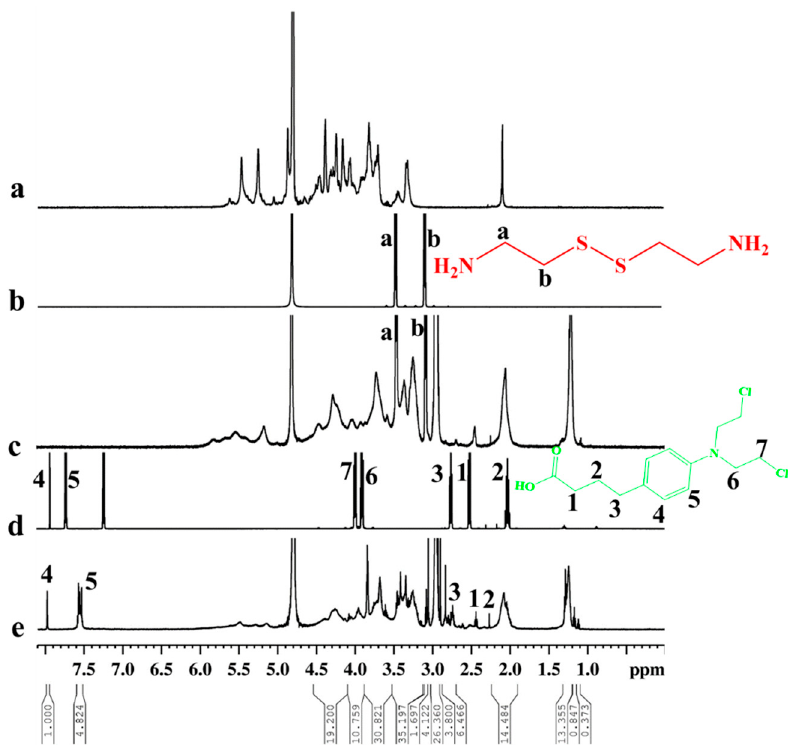
Figure 1. 1 H NMR spectra of Hep ( a ), cystamine (Cys) ( b ), Hep-Cys ( c ), Chl ( d ), and Hep–Chl ( e ) conjugate. CDCl 3 is used as a solvent for Chl and D 2 O for others.